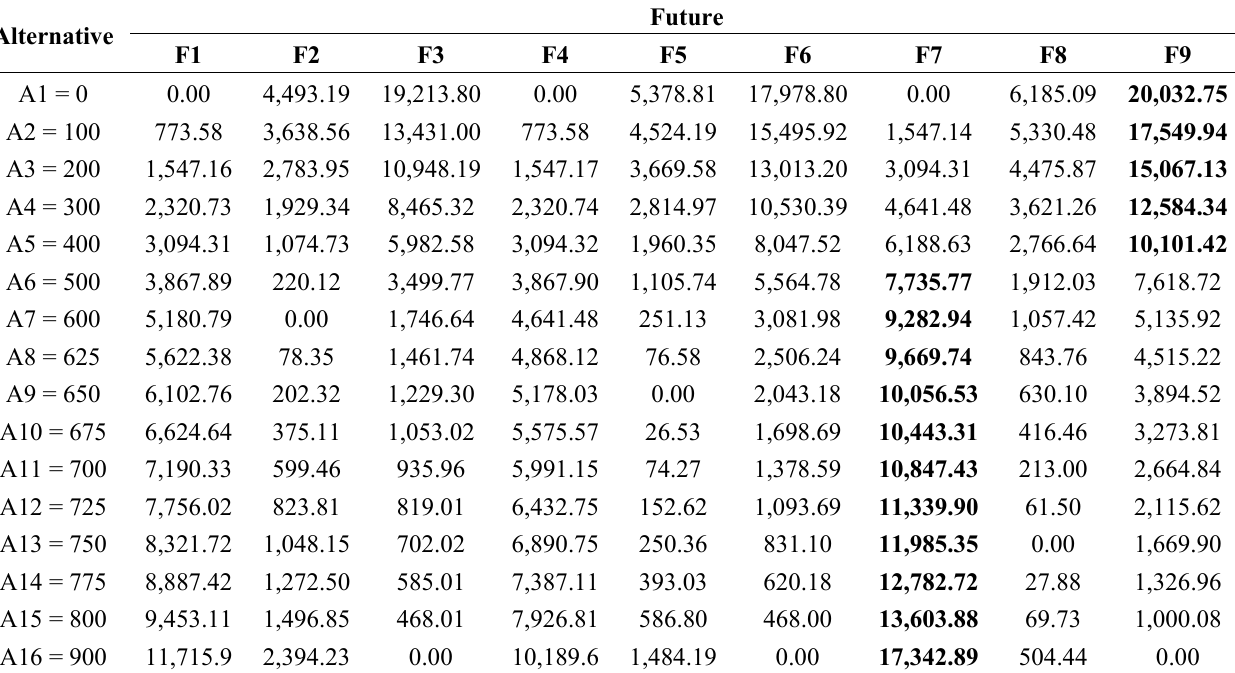
Table 5. Decision matrix of weighted regrets ($)—Case 2.